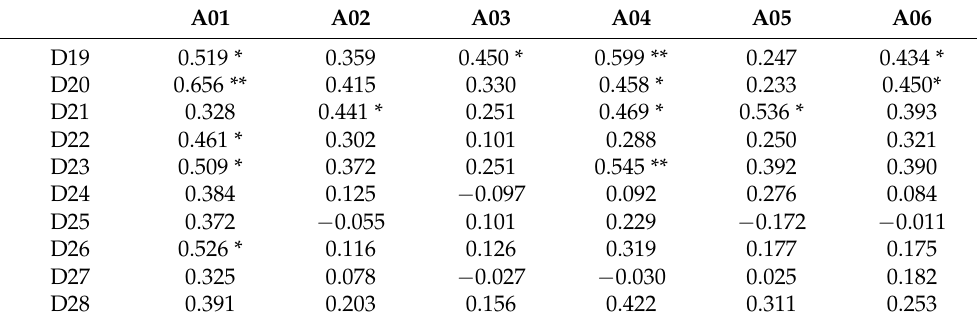
Table 3. Spearman correlation analysis between personnel and